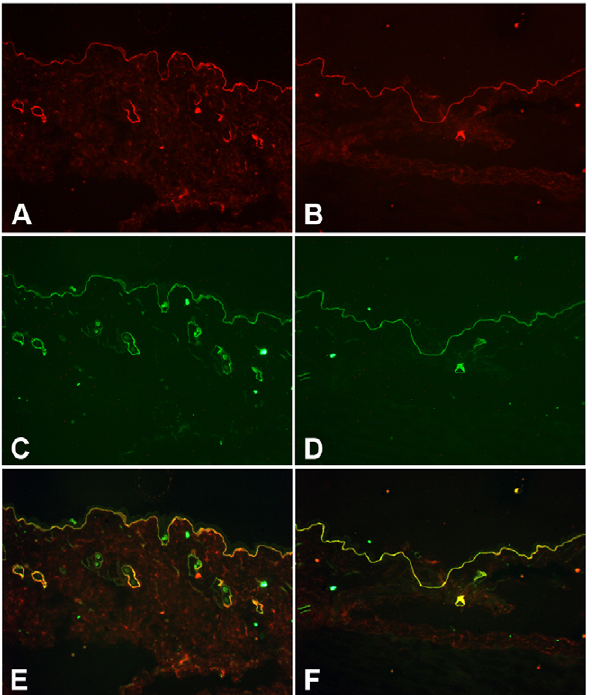
Figure 4. Human laminin c 2 colocalizes with mouse laminin a 3 and ß3 chains in rescued Lamc2 KO skin. Frozen skin tissue sections from adult rescued Lamc2 KO mice were subjected to immunofluorescence staining for human laminin c 2 (A and B), mouse laminin a 3 (C), and mouse laminin ß3 (D) using species-specific anti- laminin c 2 antibodies. Merged images are shown (E and F). Yellow color in panels E and F indicates colocalization.